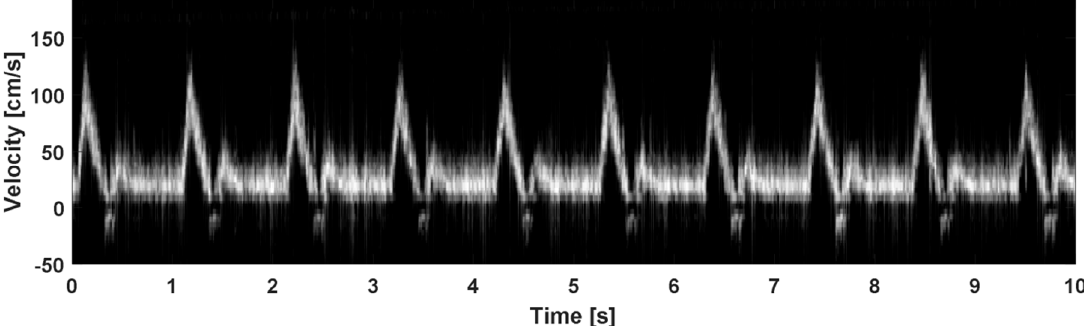
Figure 7. Doppler spectrogram obtained from the developed wireless carotid wearable ultrasound Doppler system prototype (PRF = 6